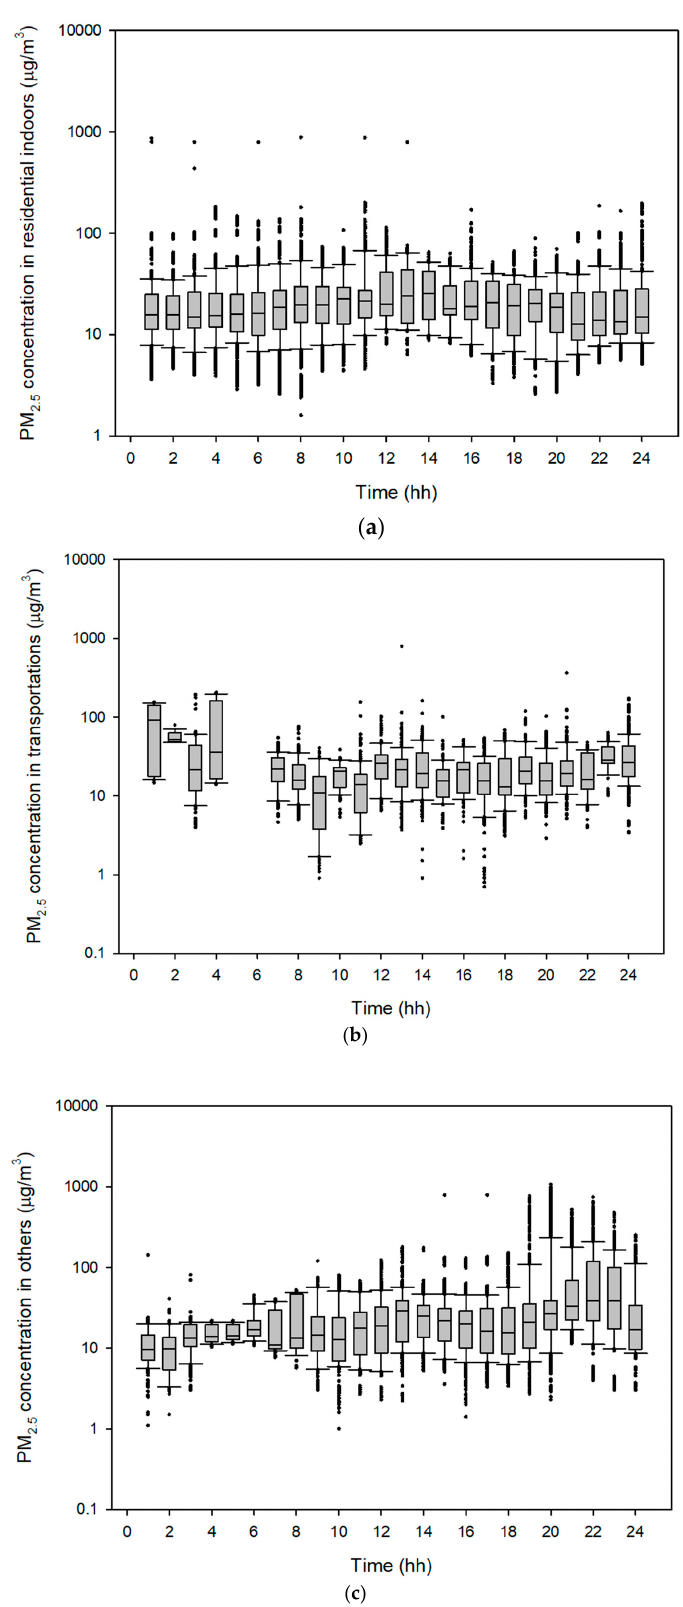
Figure 1. Fine particulate matter (PM 2.5 ) concentrations in: ( a ) The residential indoors, ( b ) transportation, and ( c ) “other” microenvironment categories. Each bar represents the concentration in 1 h interval. The figures with every 10 min interval are provided in supplement (Figure S1).